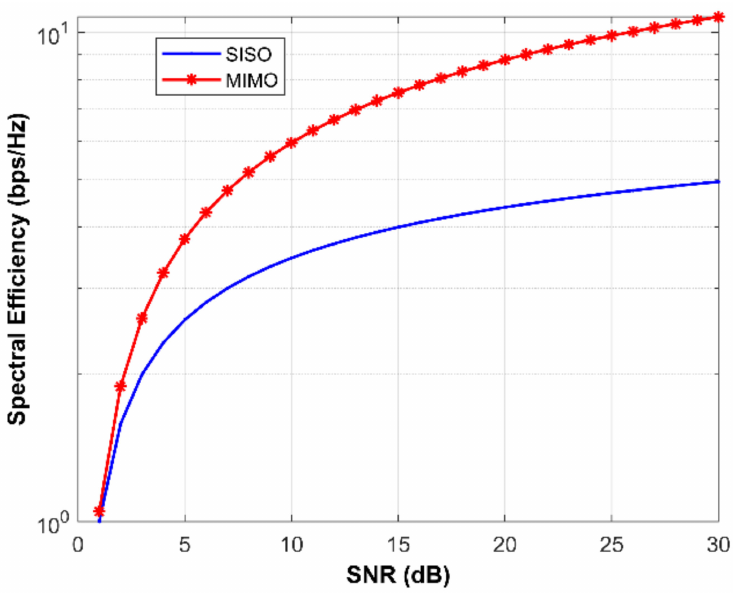
Figure 21. The channel capacity of the proposed MIMO